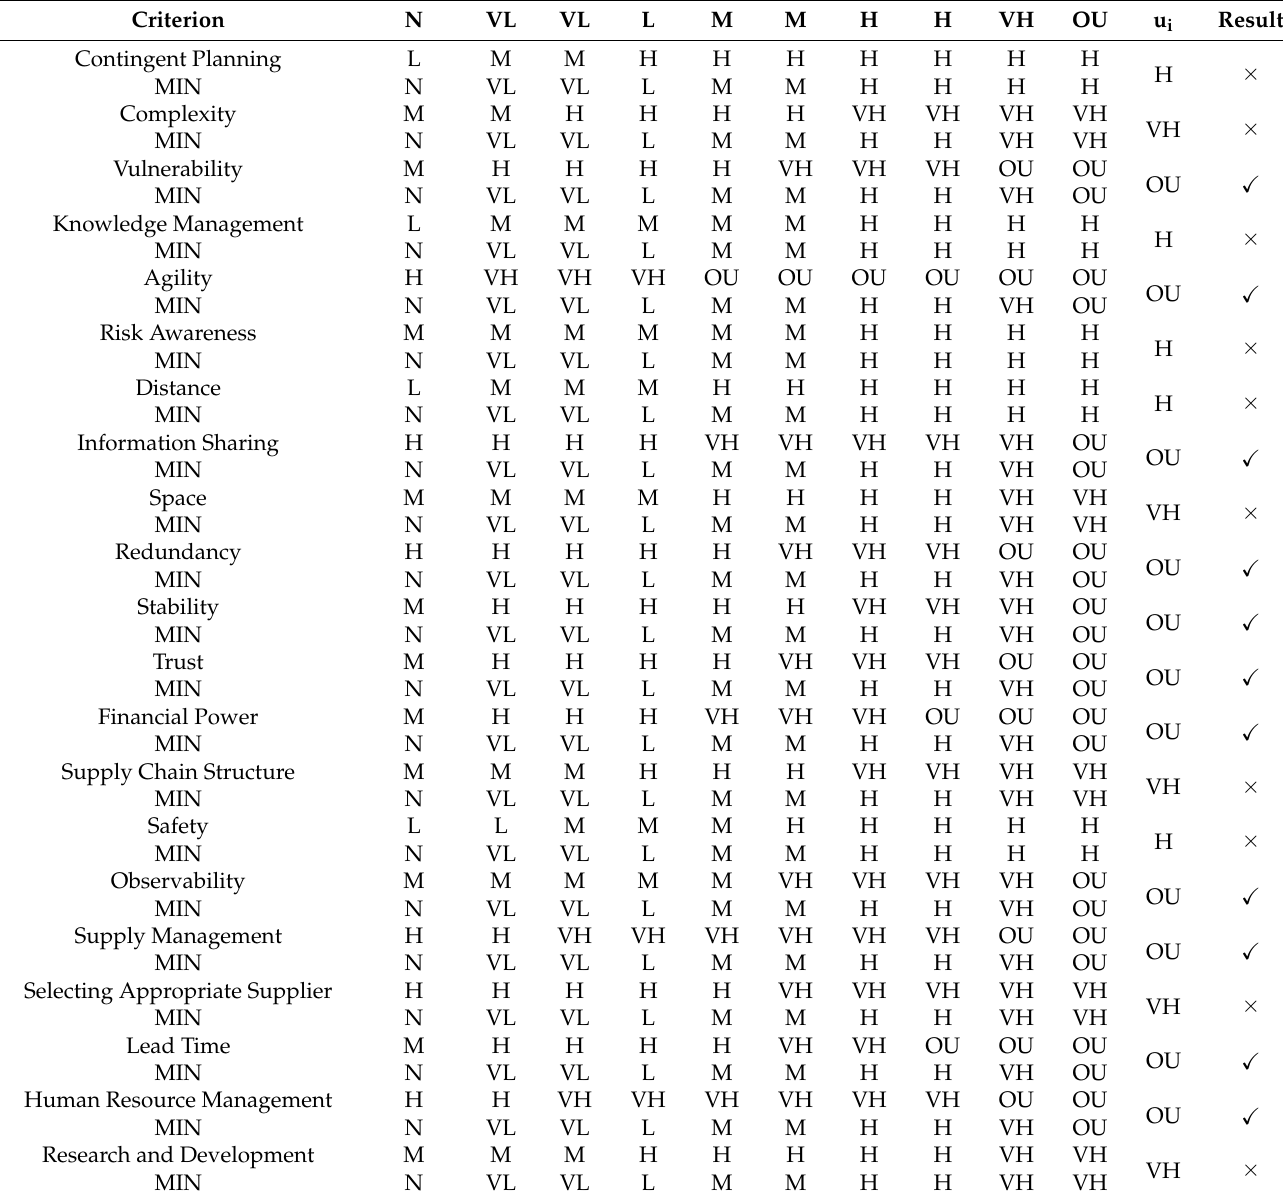
Table 5. Fuzzy screening